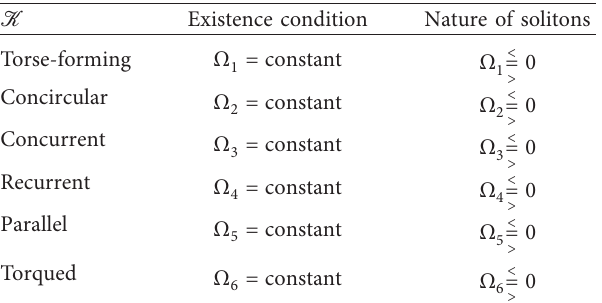
Table 4: Relationship between K , existence condition, and nature of solitons.